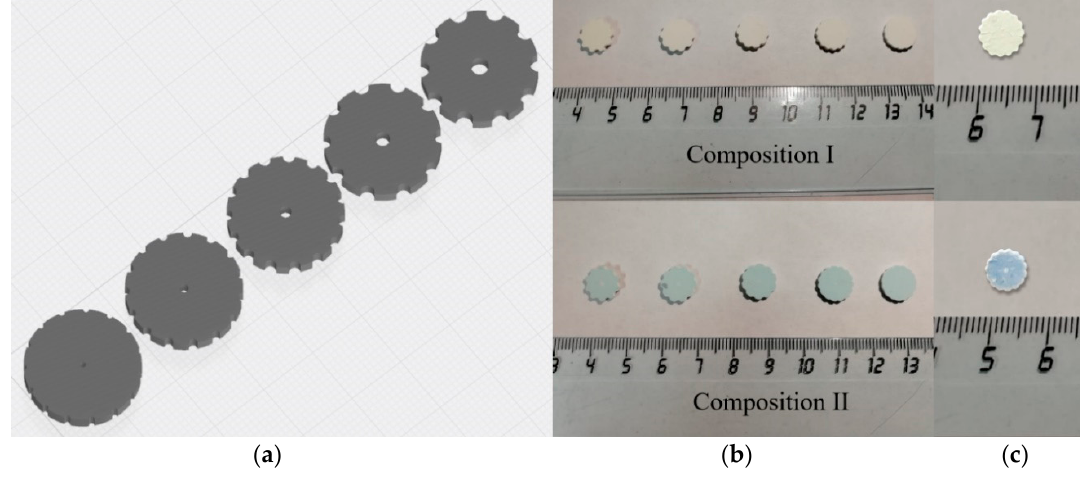
Figure 13. The CAST model ( a ), DLP printed ( b ) and sintered ( c ) optical photo